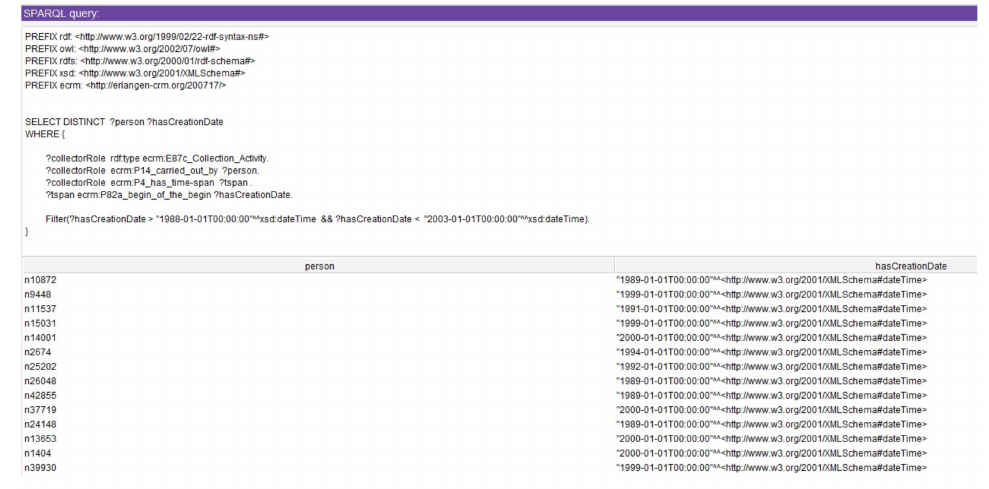
Figure 13. SPARQL query about collectors between 1988 and 2003.